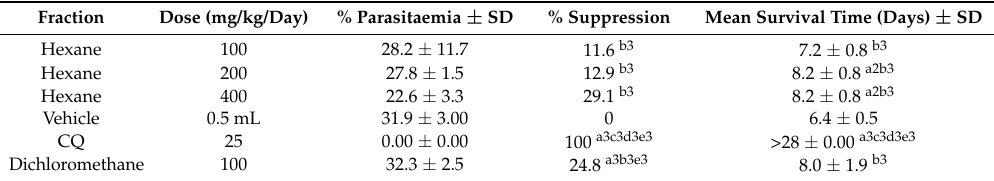
Table 3. Percentage suppression and mean survival time of Plasmodium berghei- infected mice after administration of solvent